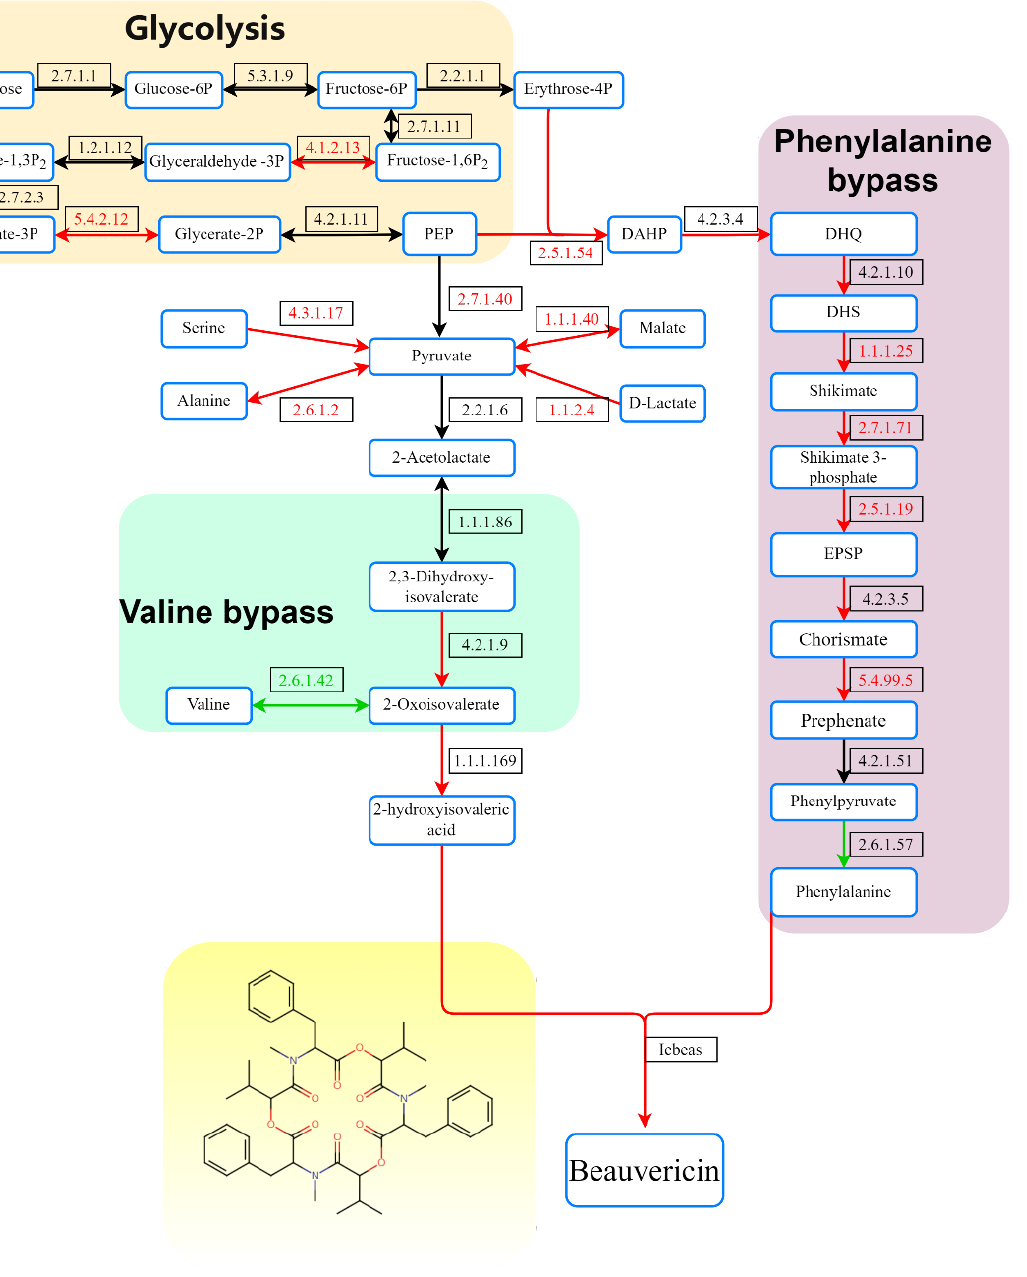
Figure 6. Metabolic and biosynthetic pathways of BEA in C. chanhua . PEP, phosphoenolpyruvate; DAHP, 3-deoxy-a-arabinoheptulonic acid-7-phosphate; DHQ, dihydroquinoline; DHS, dehydroshikimic acid; EPSP, 5-enolpyruvylshikimic acid. Shaded to indicate upregulation of the gene or pathway (red, upregulated; green, downregulated; black, unchanged). Table 2. Genes involved in BEA metabolism network.